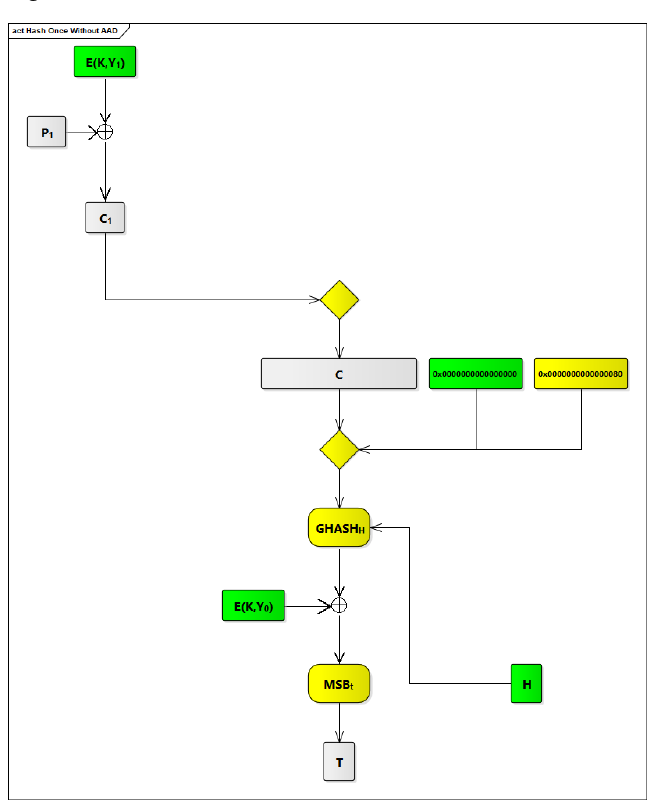
Figure 15. Hash once instruction flow.